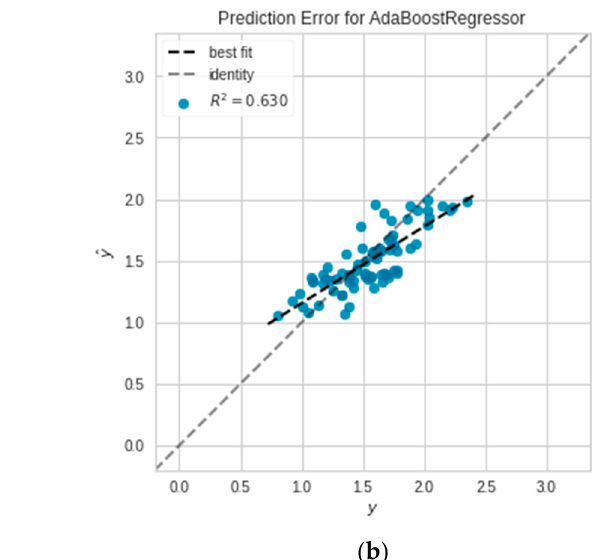
Figure 9. Prediction error of ( a ) Extra Tree; ( b ) AdaBoost.